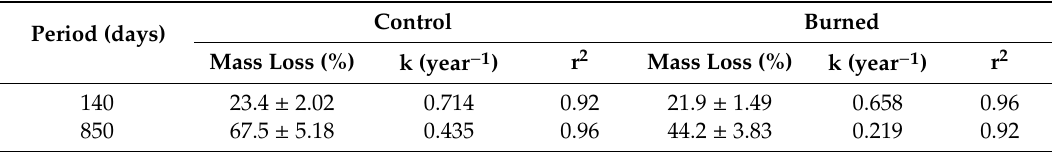
Table 2. Mass remaining and decomposition constant (k, year − 1 ) for two study sites. Data are means ± SE (n = 6).